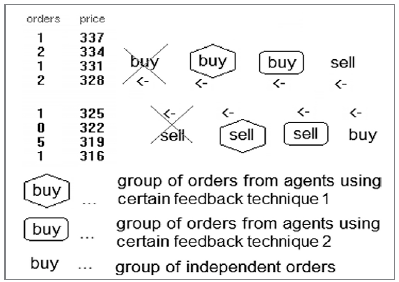
Fig. 1. Matching of orders from different techniques Source: created by